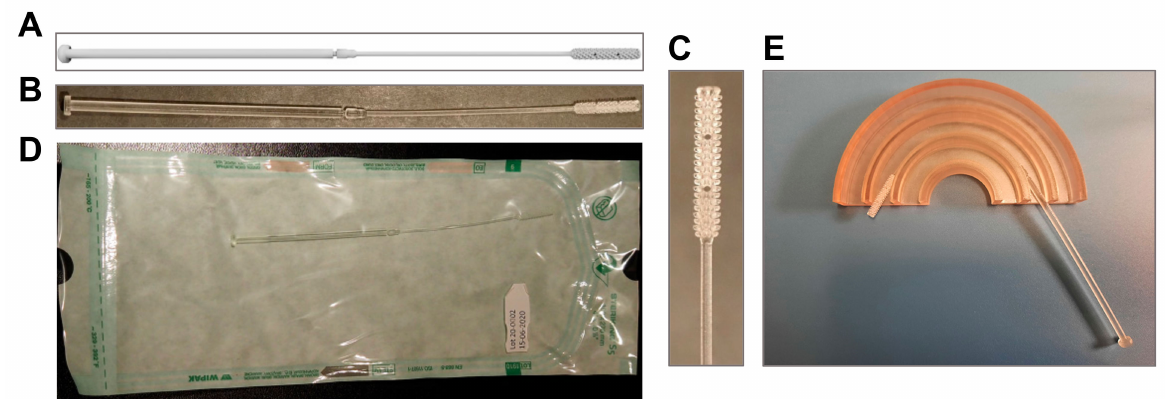
Figure 1. In-house 3D-printed swab model. Design of the Northwell 3D swab model with the addition of a breakout point ( A ) used to 3D-print swab in our hospital ( B , C ). Swabs were individually packed in autoclavable and vacuum-sealed pouches ( D ) for sterilization. ( E ) Flexibility was mechanically tested using semicircular canals (radius of 15, 25, and 35